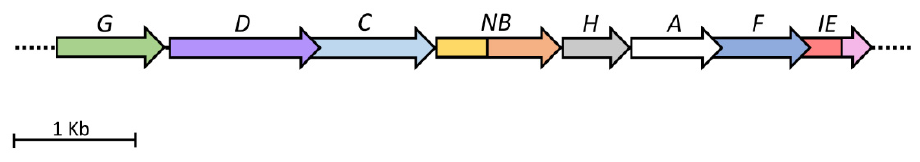
Figure 3. Schematic representation of Escherichia coli his operon.